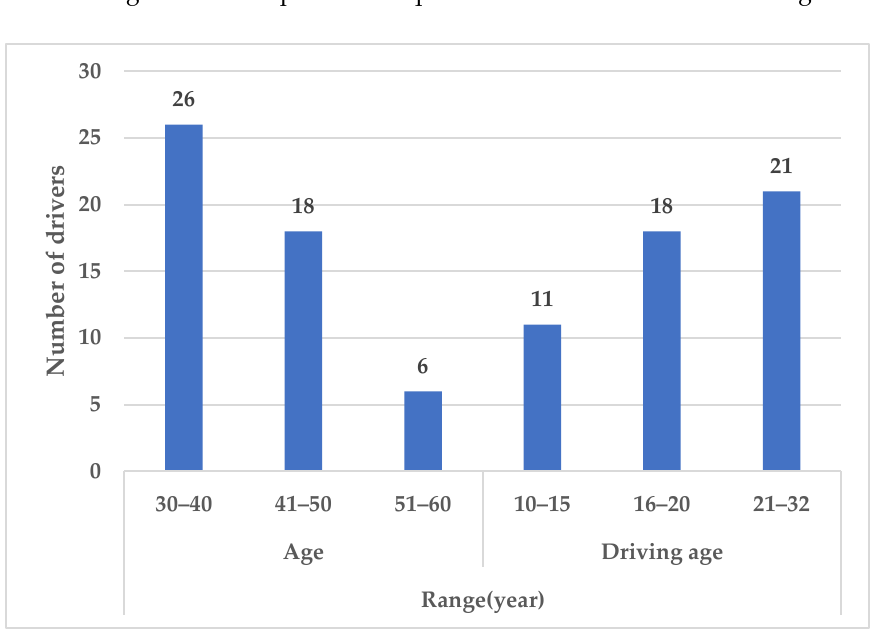
Figure 1. Basic information about drivers.